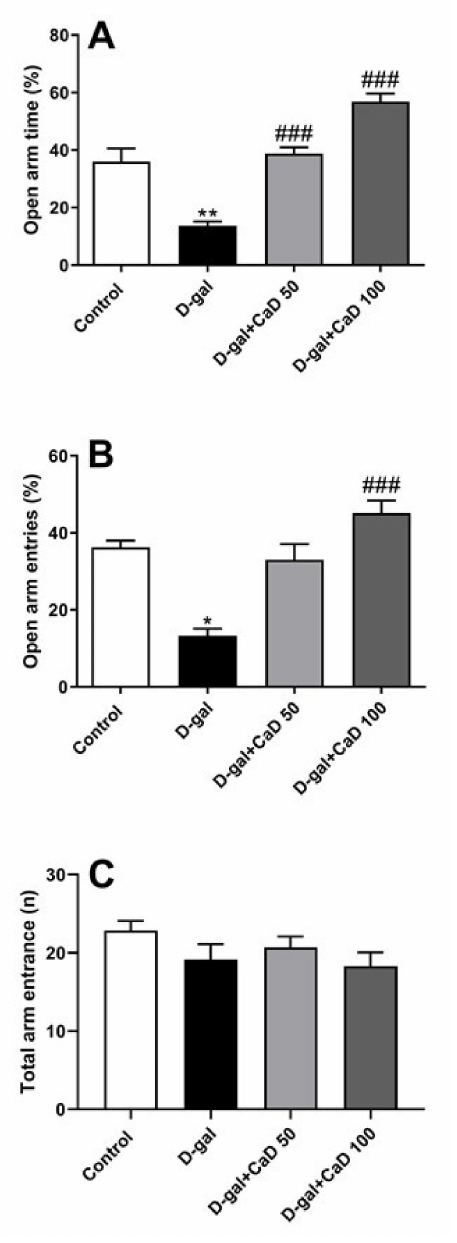
Figure 2. Effect of calcium dobesilate (CaD; 50 and 100 mg/kg, p.o.) in control of mice anxiety-like behavior induced by D-gal. Behavior was evaluated by elevated plus-maze. ( A ) Open arm time, ( B ) Open arm entries and ( C ) Total arm entrance. Values are mean ± SEM ( n = 7 in each group). * p < 0.05 and ** p < 0.01 as compared to control group; ### p < 0.001 as compared to D-gal treated